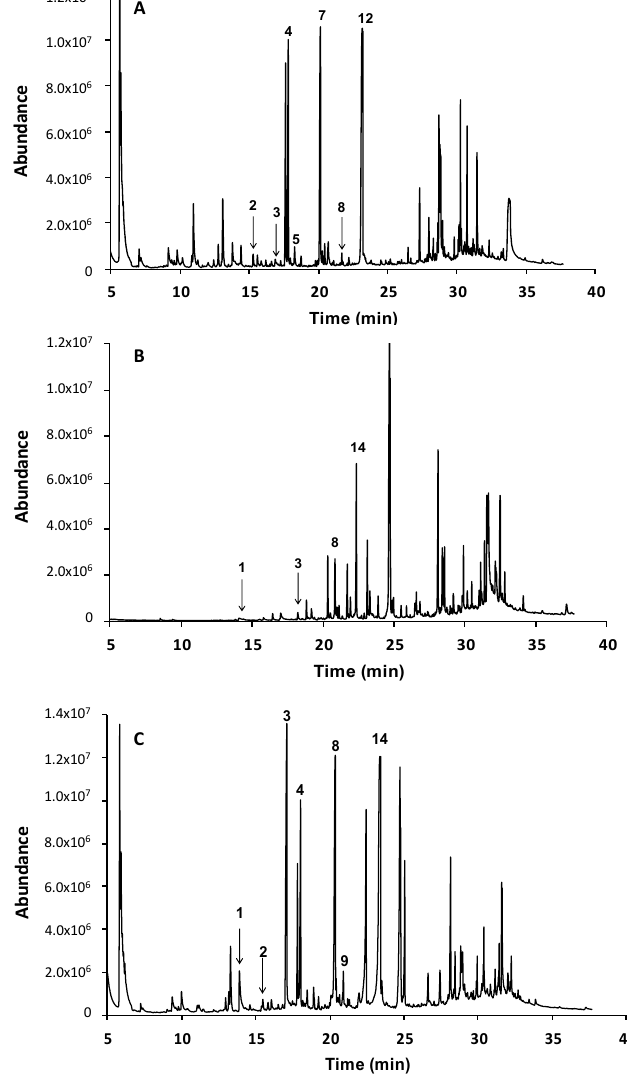
Figure 2. Profile of Q. petraea according to ( A ) EHP-A ; ( B ) EHP-B ; ( C ) EHP-C. Peak numbers identify the compounds as reported in Table Figure 2. profile of Q. petraea according to A ) EHP-A ; B ) EHP-B ; C ) EHP-C. Peak numbers identify the compounds as reported in Table 1.